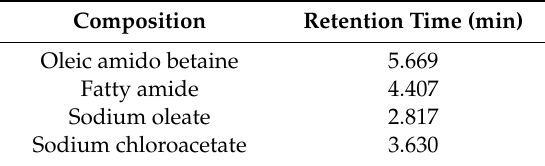
Table 3. Unwashed as-synthesized surfactant composition and retention time.